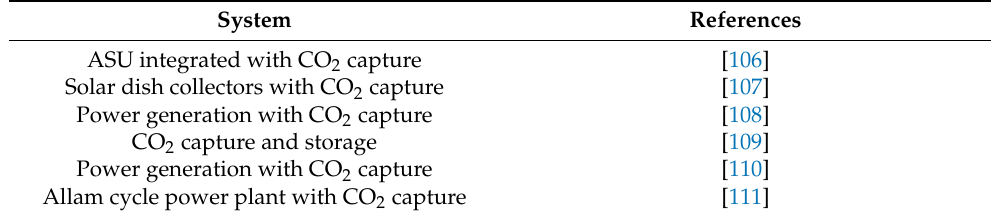
Table 5. Other works on CO 2 capture system using cold energy from LNG